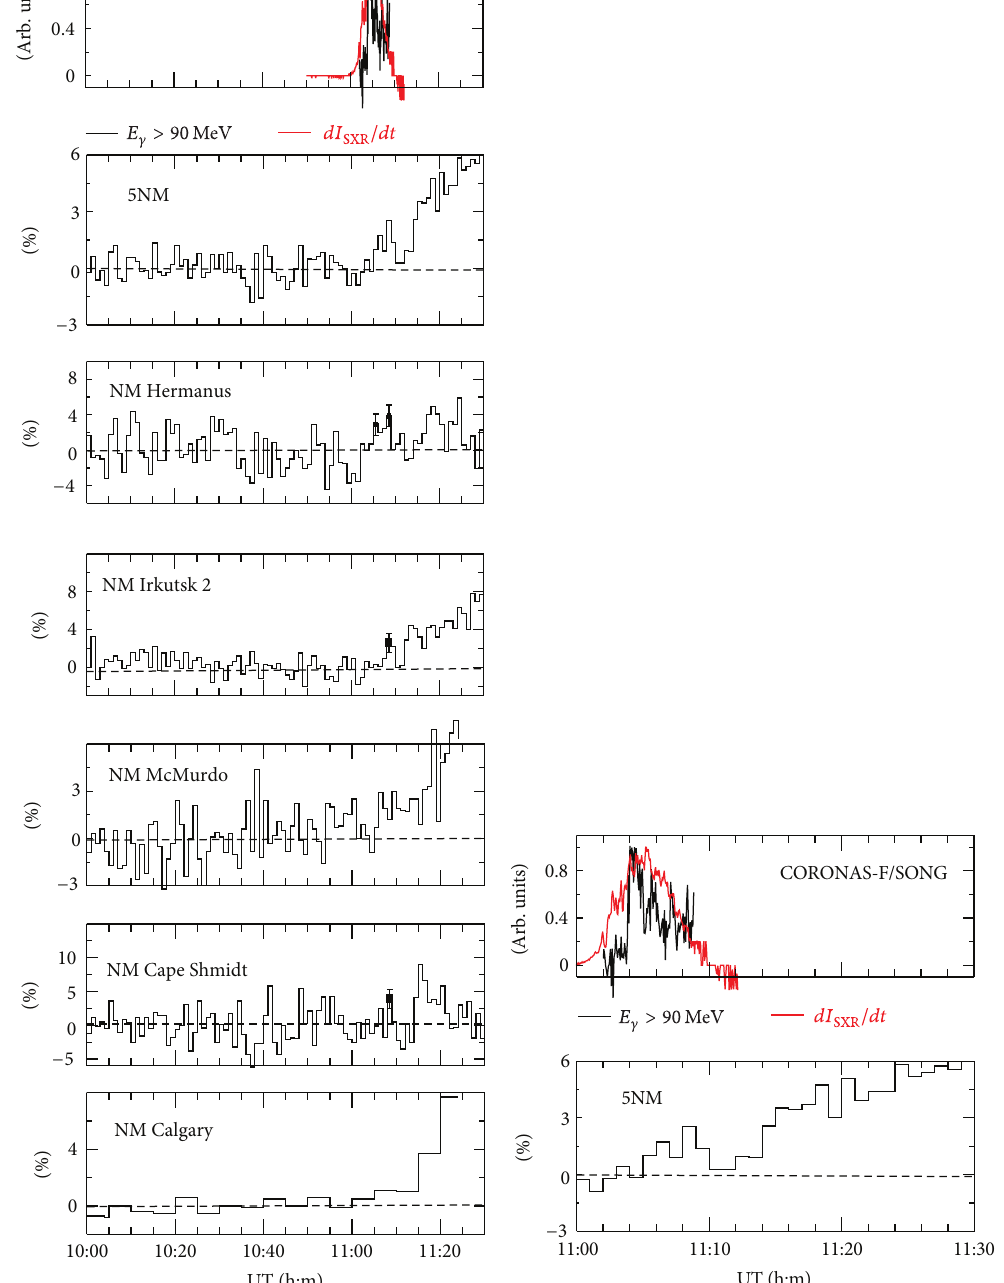
Figure 11: GLE 65, October 28, 2003. The left part, upper panel: SONG gamma-rays (black curve) and the soft X-ray derivative (red curve). The second panel: count rates of five NMs obtained by the method of superposed epoch. Five panels below: data of each NM separately. Right part: two upper panels from the left part displayed with better time